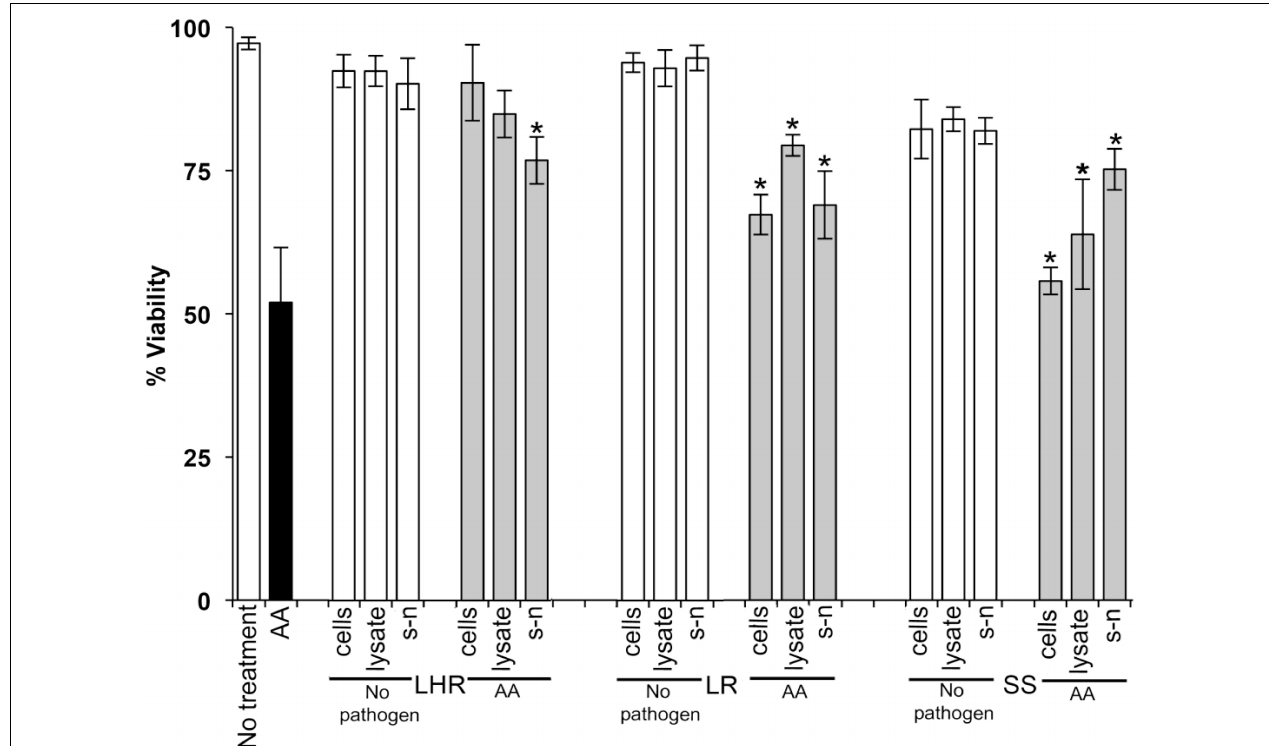
FIGURE 2 | The protective effects of candidate probiotics for human oral keratinocytes against A. actinomycetemcomitans. All probiotic cells, cell lysates, and culture supernatants protect HOKs against A. actinomycetemcomitans . HOKs were inoculated with either live L. rhamnosus GG (LHR), L. reuteri (LR), or S. salivarius K - 12 (SS) cells, lysates and supernatants (s-n) (white bars) or simultaneously in combination with A. actinomycetemcomitans (AA) (gray bars). All experiments were performed for a minimum of three biological replicates, with three technical replicates each time. All data are shown as mean values plus/minus standard deviations. Results expressed as the mean ± SEM, * p <